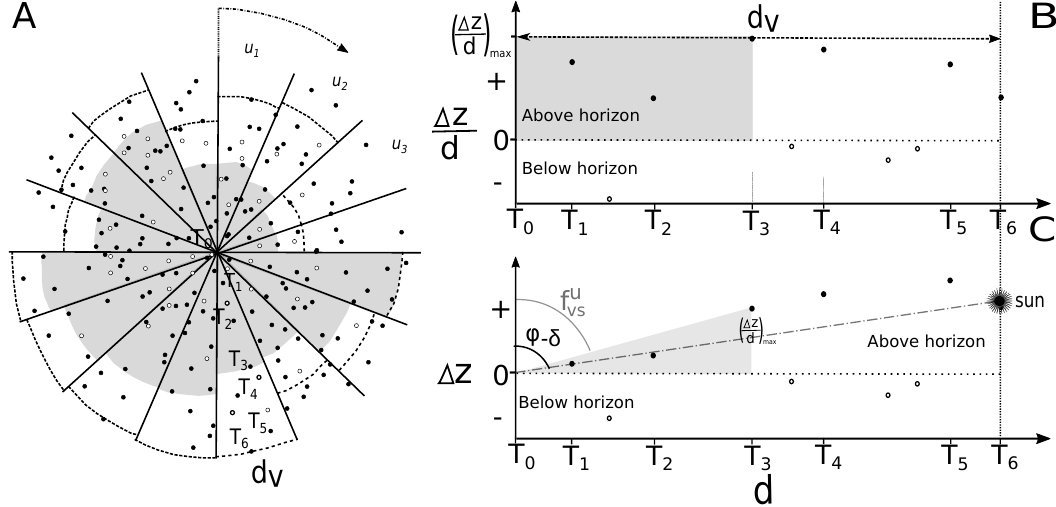
Figure 5. Remote shading calculation in unstructured meshes. ( A ) Radial search for sky-blocking domain elements to each pivot (i.e., T 0 ) along n search slice directions ( n = 16 in this example case). Dark and hollow circles represent included (higher) and discarded (lower) elements within each slice. The dotted lines represent the maximum horizon visibility, d v , and the grey-shaded areas extend to the sky-blocking element from T 0 . For a particular slice search direction (e.g., SSE) several neighboring elements above the horizon (e.g., z(T 0 ) < z(Ti) with i = 2, 3, 4, 5, 6) are included by testing that their horizontal azimuths fall between the slice limits (e.g., 67.5 ◦ and 90 ◦ ); ( B ) ∆ z/d Vs. d for the TIN elements within the SSE search slice. Note that T 3 is the sky-blocking element along this direction; ( C ) Zenith angle ( f u vs ) calculation of the line of sight between the pivot T 0 and the sky-blocking vertex T 3 . Note that T 3 is within the observable horizon distance d v . The sun zenith angle ( φ − δ ) is also calculated in terms of the distance, d , and the difference in elevation ∆ z . In this case since f u vs < ( φ − δ ) then T 0 is shaded by T 3